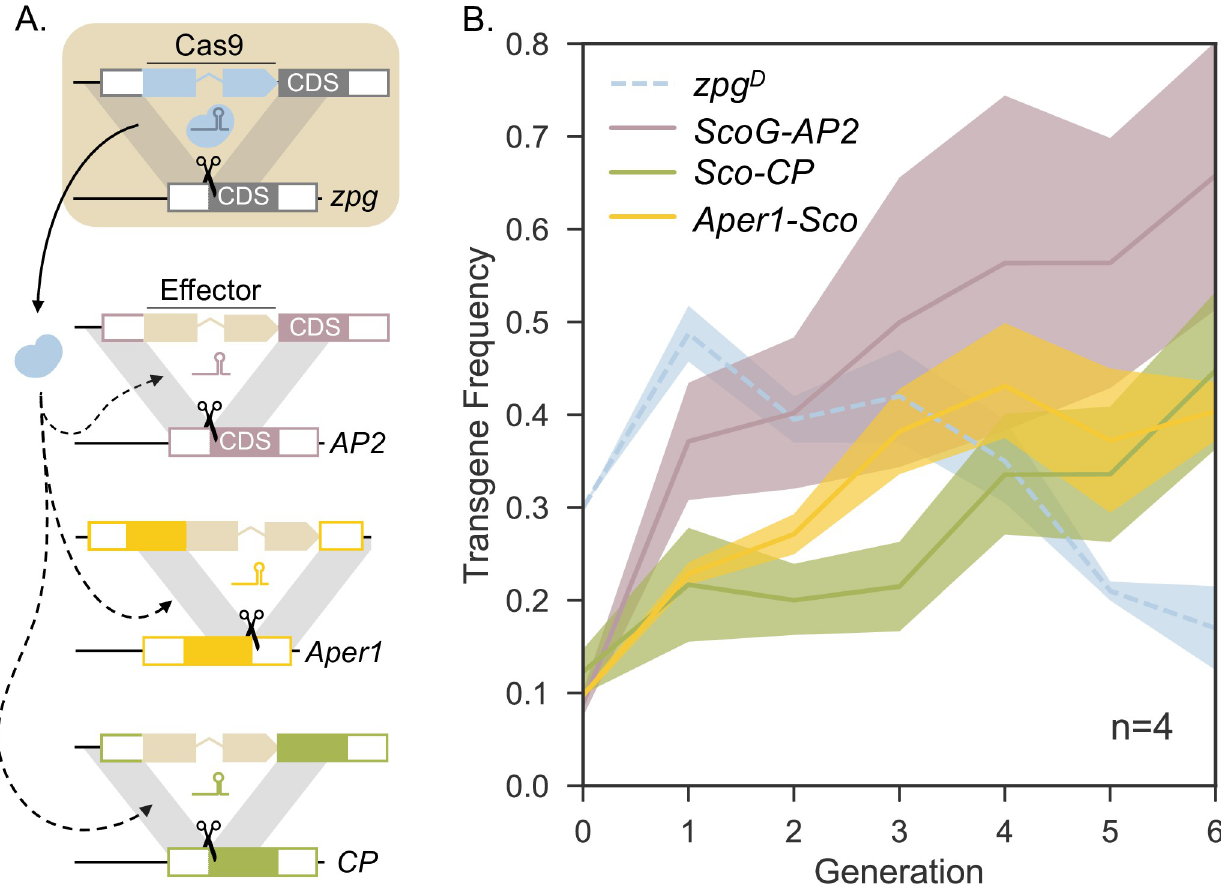
Fig 4. zpg D self-eliminates but drives the spread of three non-autonomous payload genes across four independent caged populations. A: Illustration of zpg D -dependent homing at the three non-autonomous integral gene drive loci. The germline-expressed Cas9 forms a complex with U6-driven gRNAs expressed by and specific to each effector construct. B: Transgene frequency of each construct estimated by either fluorescence ( zpg D ) or multiplex PCR. Solid lines and shaded areas indicate the means ± 68% bootstrap CI respectively for zpgD (blue), ScoG-AP2 (purple), Sco-CP (green) and Aper1-Sco (yellow). 47 individuals and one negative control were genotyped per cage and per generation. Cages contained ~600 individuals in total.